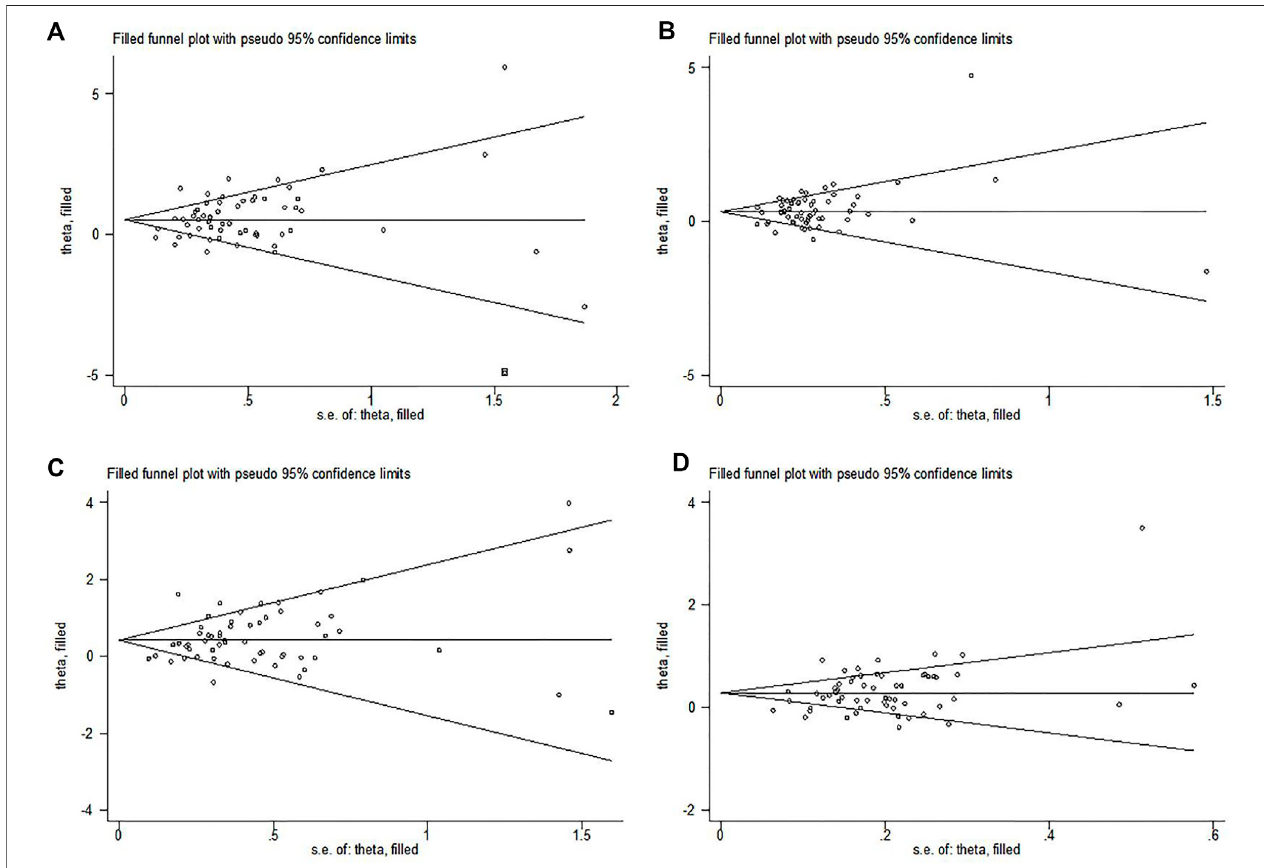
FIGURE 3 | Trim-and- fi ll plots of the publication bias to assess MTHFR C677T polymorphism in the overall population. (A) Allelic model, T vs. C; (B) dominant model, TT + TC vs. CC; (C) recessive model, TT vs. CC + TC; (D) homozygote genetic model, TT vs. CC.